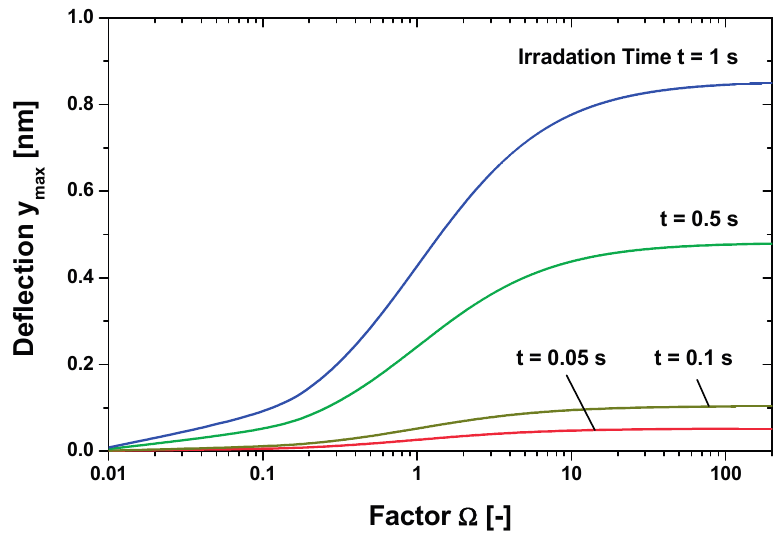
Figure 7. Maximum central deflection, y max , at r = 0 of a circular membrane (silicon, 1 µm thickness) as function of factor Ω and irradiation time for a water-filled cavity. IR power density: 10 W/m 2 , diameter and height of the cavity: 0.5